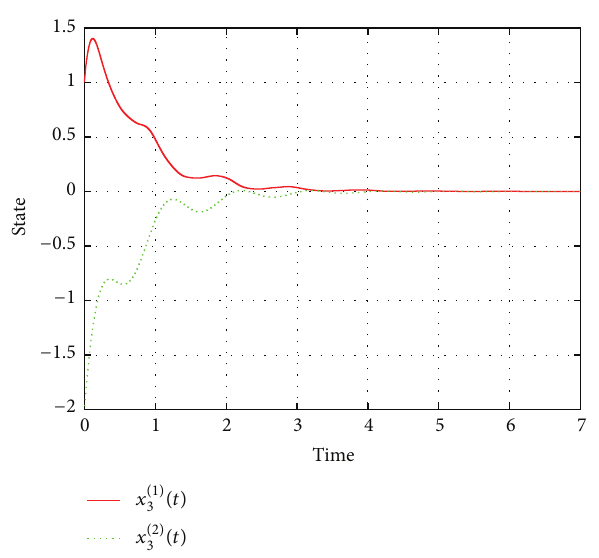
Figure 3: Time histories of 𝑥 3 (𝑡) .